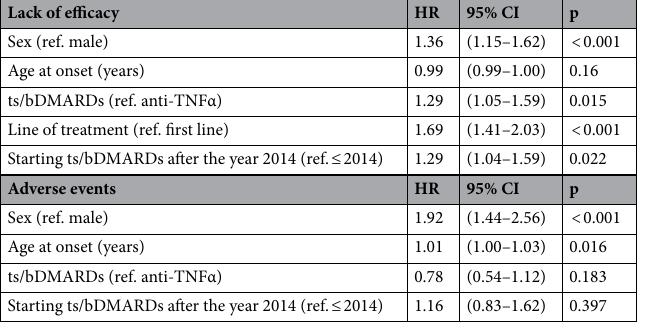
Lack of efficacy HR 95% CI p Sex (ref. male)